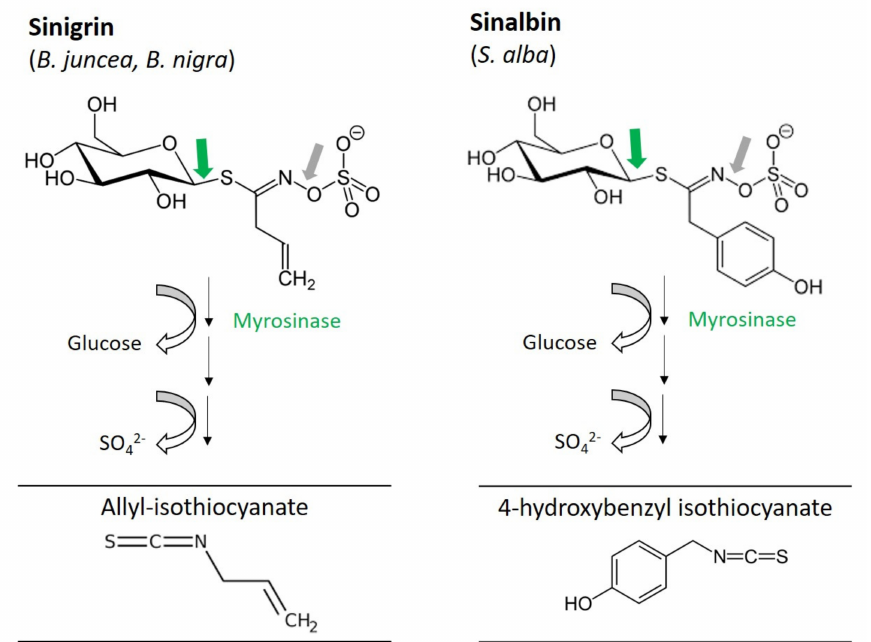
Figure 3. Main glucosinolates and corresponding hydrolysis products in brown ( B. juncea ), black ( B. nigra ) and white ( S. alba ) mustard